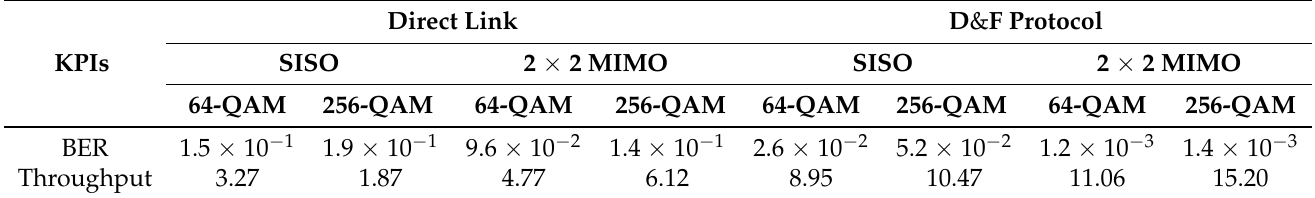
Table 2. Summary of results: With D&F relay node vs. direct link for P BS = 15 dBm.